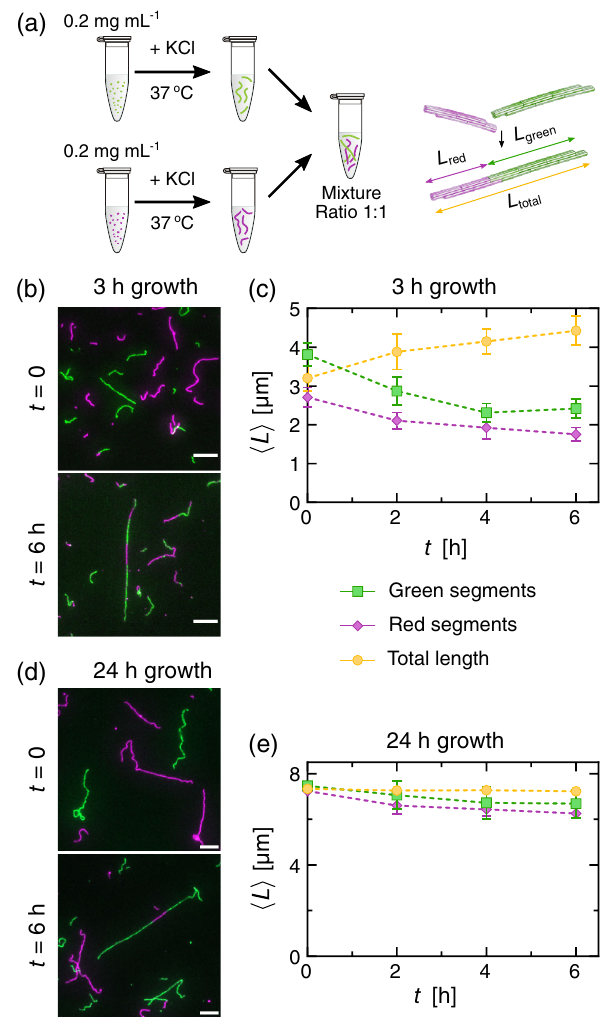
FIG. 5. Annealing and fragmentation of vimentin filaments occur simultaneously during assembly. (a) Schematics of the dual-color experiment. Two populations of vimentin filaments, both assembled from an initial concentration of 0 . 2 mg mL − 1 , labeled in green and red, were preassembled at 37 °C for 3 or 24 h. Then, they were mixed together at ratio 1 ∶ 1 and incubated for another 6 h. (b),(d) Fluorescence images at different time points after mixing and incubation for the filaments grown for 3 h (b) and 24 h (d). Scale bar: 5 μ m. (c),(e) Evolution of mean total length of filaments (yellow), length of red (magenta) and green segments (green) over time after mixing and incubation for the filaments grown for 3 h (c) and 24 h (e). Error bars are standard deviations over 3 repeats. Sample size: ∼ 200 filaments per condition and